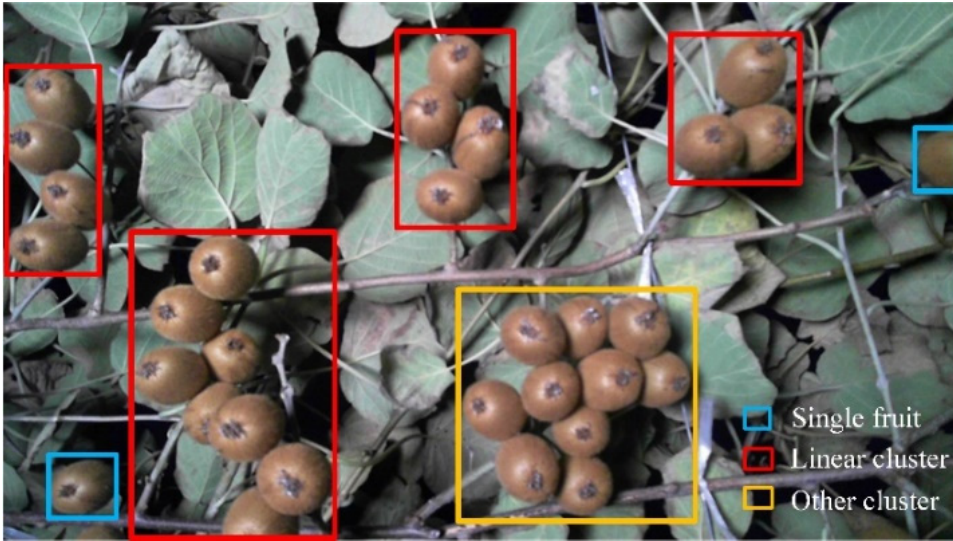
Figure 1. Distribution characteristics of kiwifruit.